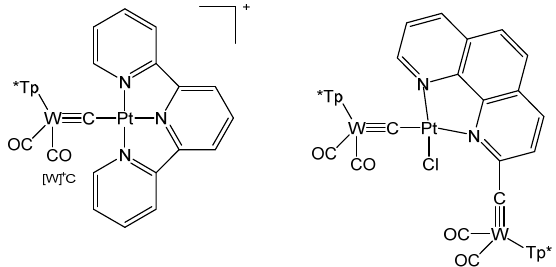
Figure 32. Tetrameric unit from [W]C → AuAsPh 3 and [W]C → AuPPh 3 [122].